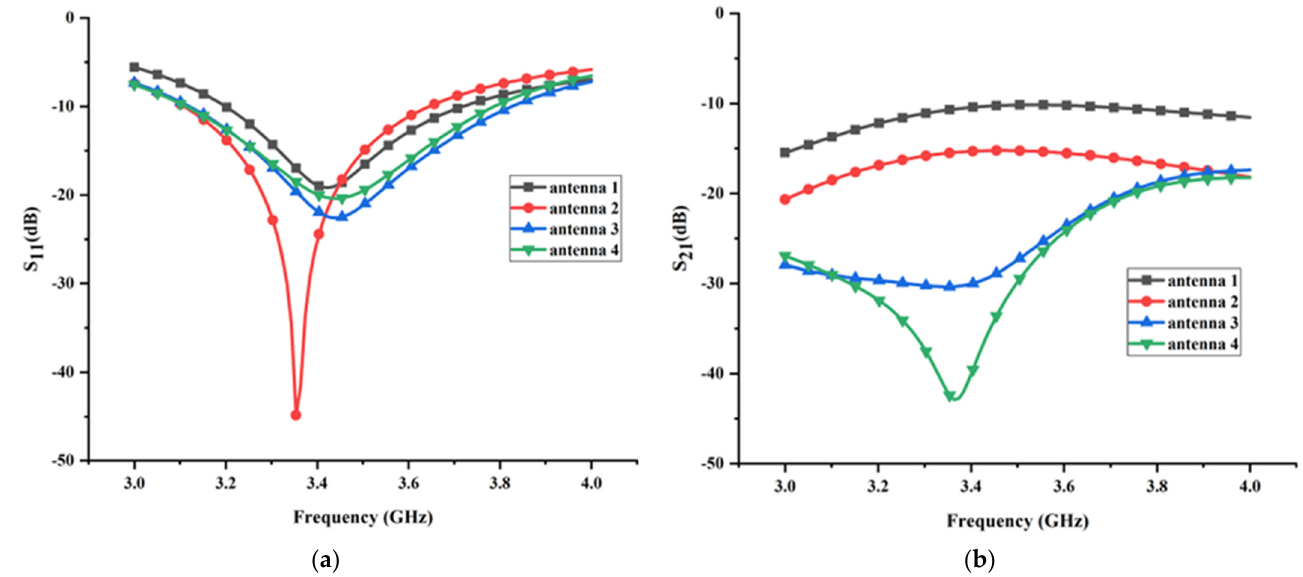
Figure 3. ( a ) The reflection coefficient of antenna 1–4; ( b ) the transmission coefficients of antenna 1–4.